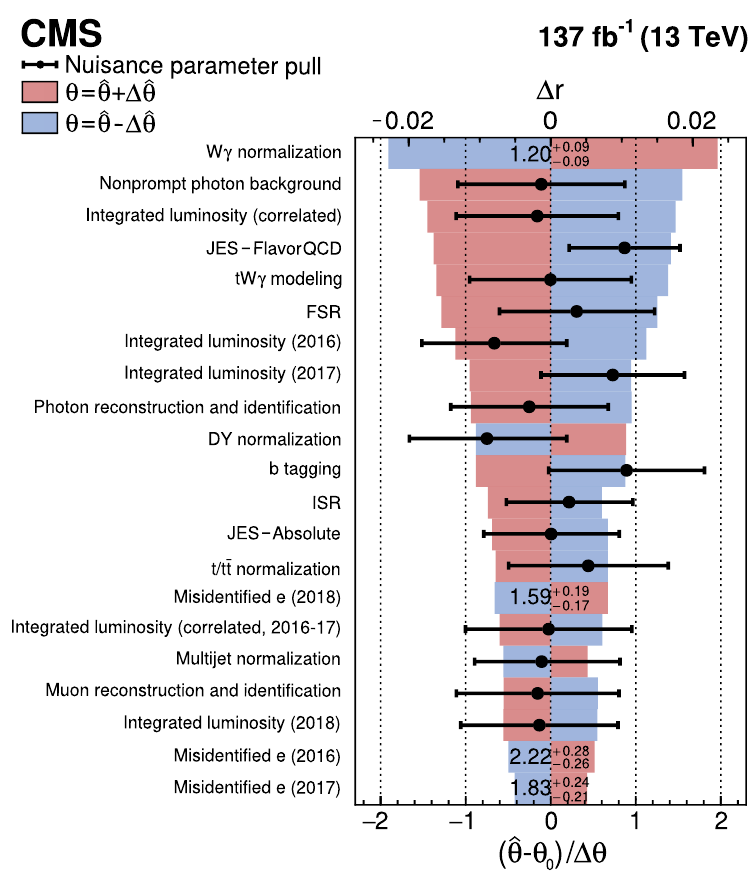
Figure 7 . Ranking of the systematic uncertainties from the profile likelihood fit used in the inclusive cross section measurement. For each uncertainty, the red and blue bands indicate the post-fit impact on the fit result. The black dots indicate the post-fit values of the nuisance parameters and the numerical values provide the extracted SFs for the misidentified electron background and the normalization of the W γ process. The black lines represent the post-fit uncertainties normalized to the pre-fit uncertainties